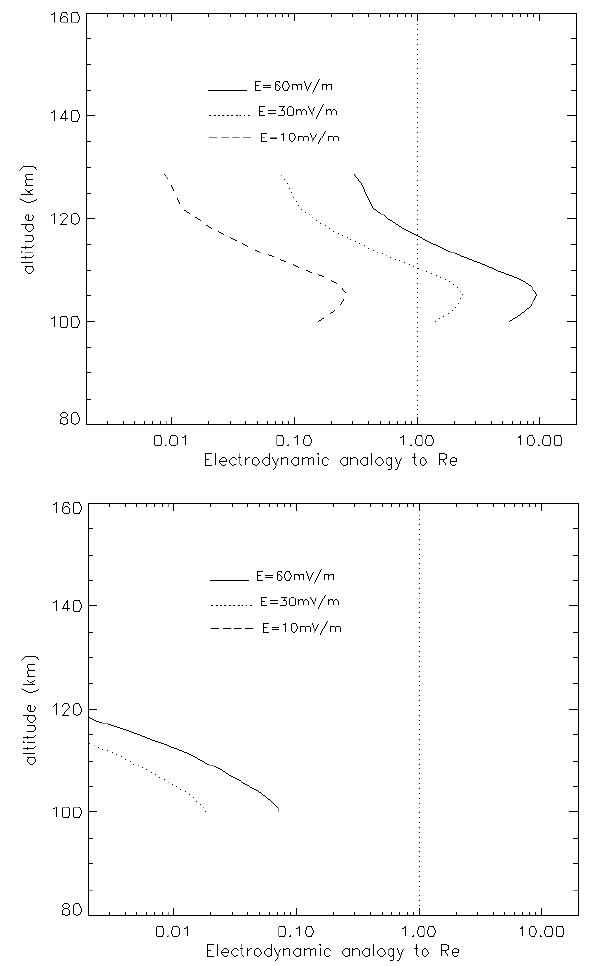
Fig. 2. The proposed analogy to the Reynolds number as a function of height. Different electric field strengths are used to derive corre- sponding plasma velocity profiles. (a) Summer case and (b) winter case. The vertical dotted lines indicate the unity